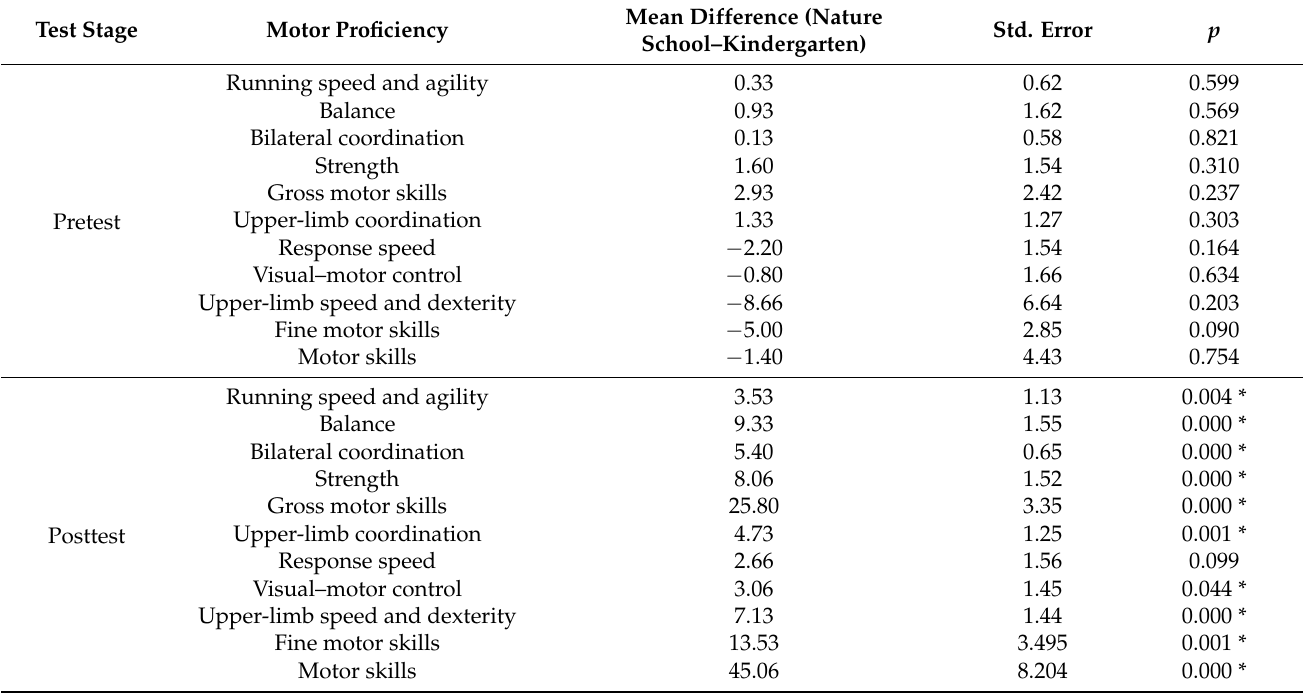
Table 1. Differences of the motor proficiencies between groups pre- and